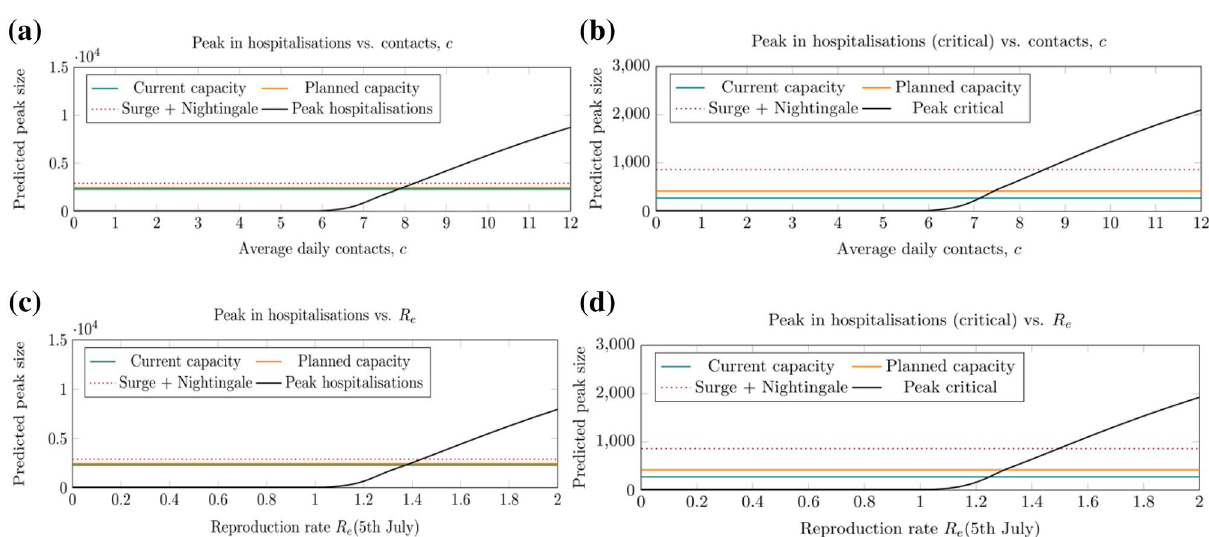
Figure 5. Predicted size of the secondary COVID-19 wave (black lines), measured by the peak in all COVID- 19 hospitalised patients (left panels) and critical care COVID-19 hospitalised patients (right panels) for different levels of compliance with social distancing from 4 July 2020 as a function of the daily number of contacts, c , (top row) and the effective reproduction number, R e (on 5 July 2020, bottom row). Estimates for hospital capacity levels (coloured lines) are given for reference. For c > 6, R e is above 1 and a secondary wave is predicted. The results shown here assume an infectiousness period of 5 days and that symptomatic infections comprise 70% of all